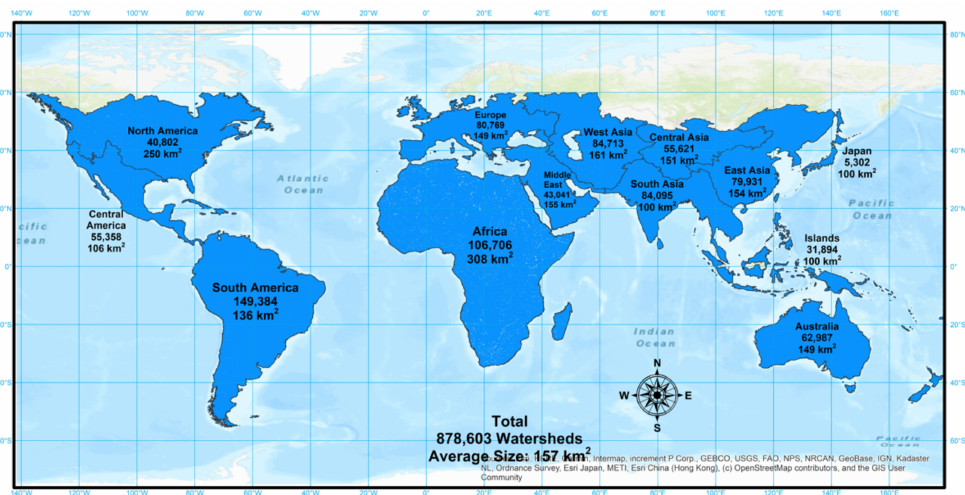
Figure 1. GEOGloWS Global Streamflow Prediction Tool World